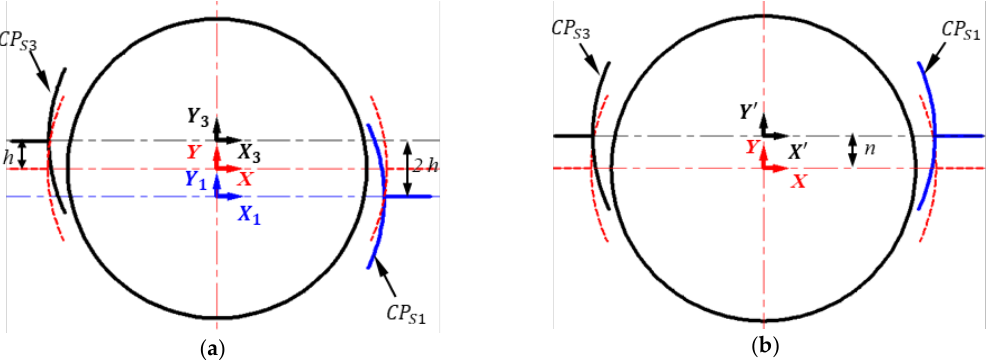
Figure 5. 2D sketch of the spherical capacitance sensor C x when the spherical capacitive plate CP S1 is radial offset from the ideal position. ( a ) CP S1 and CP S3 are misaligned, ( b ) CP S1 and CP S3 are aligned. (A) Displacement of CP S1 and CP S3 along opposite directions